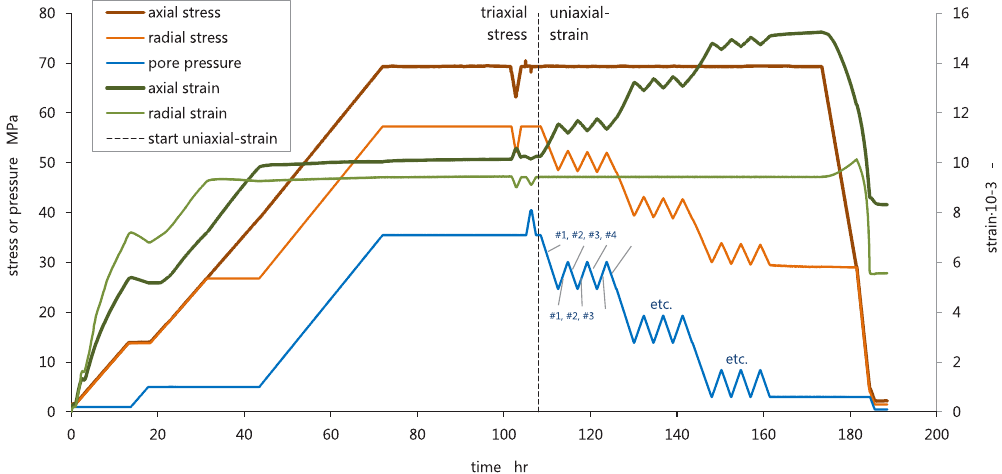
Figure 1. Axial stress, radial stress, pore pressure (left axis), and axial and radial strains (right axis), versus time, plotted for a complete test following the UPPD/M protocol. Sample ZRP-3A_123D is here first loaded to in-situ stress and pore pressure conditions (0–70 hr), then stabilized (70–105 hr), and finally depleted under uniaxial- strain boundary conditions (105–180 hr, with zero change in radial strain). The core of the UPPD/M protocol consists of three pore pressure steps (35 MPa to 25 MPa, 25 MPa to 15 MPa, and 15 MPa to 3 MPa) that are each followed by three inflation-deflation steps (note the spikes in pore pressure, radial stress, and responding axial strain). All inflation and deflation steps were sequentially numbered, e.g. the inflation steps number from #1 to #9, whereby steps #3, #6, and #9 were parameterized as purely elastic response. The tangent of the